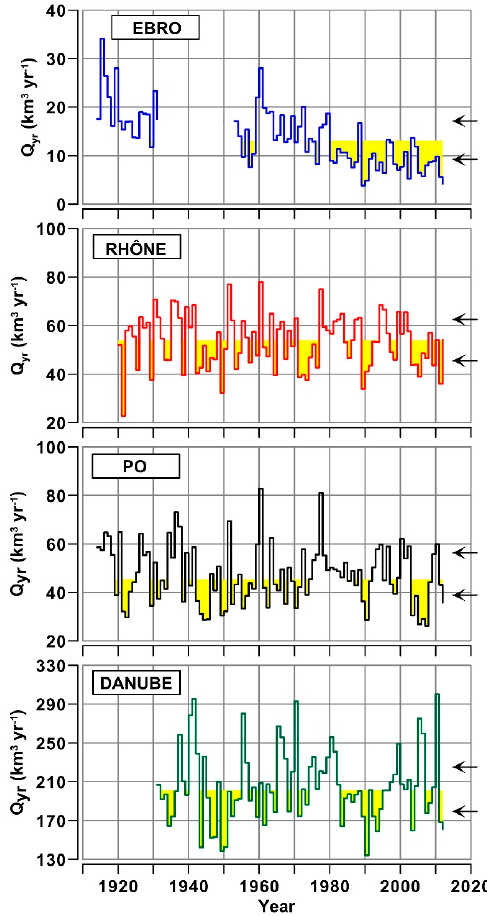
Figure 3. Time series of annual discharge (Q yr ; km 3 yr − 1 ) of the Ebro, Rhône, Po and Danube during the last century. Yellow areas indicate the median of water discharge and the arrows indicate 1st and 3rd quartile (data in Table 1).